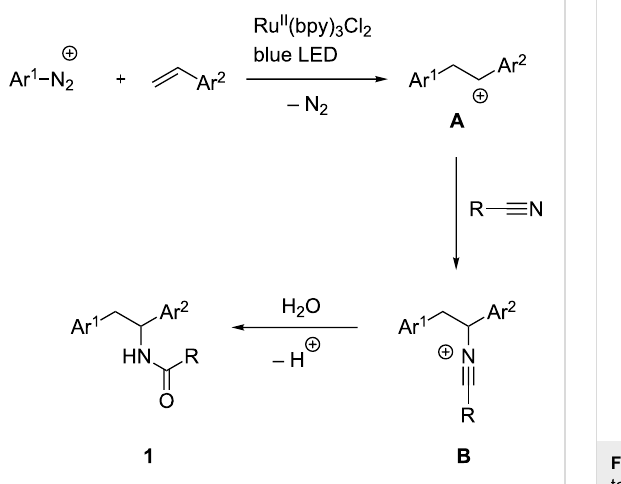
Scheme 1: Photo-Meerwein reaction leading to amides.